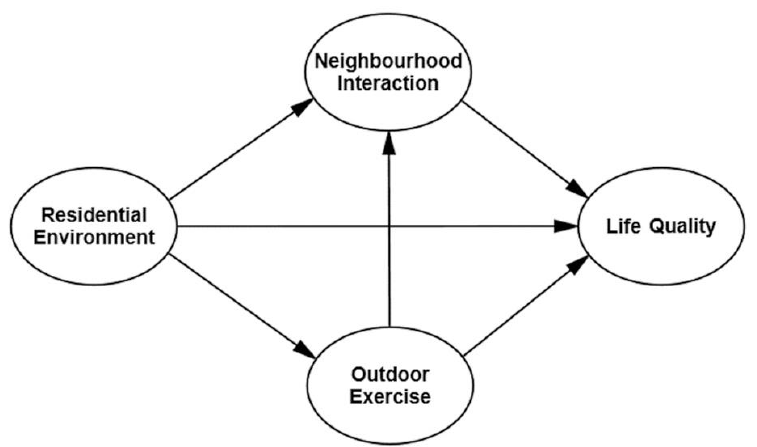
Figure 1. Social–ecological model of “residential environment–individual behavior–life quality Figure 1. Social –ecological model of “residential environment– individual behavior – life quality relationship of older relationship of older adults”.